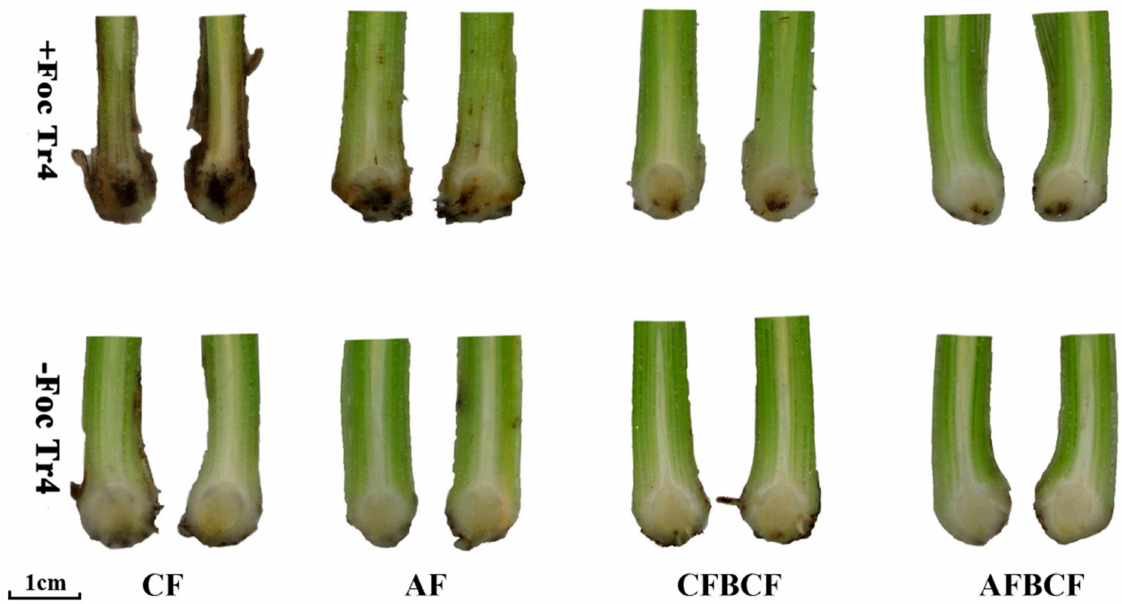
Figure 2. Comparison of browning degree of banana rhizome 60 days after Foc Tr4 inoculation. CF stands for conventional fertilizer. AF stands for alkaline fertilizer. CFBCF stands for conventional fertilizer and biocontrol fungi. AFBCF stands for alkaline fertilizer and biocontrol fungi. Table 1. Browning section area of banana rhizome 60 days after Foc Tr4 inoculation.